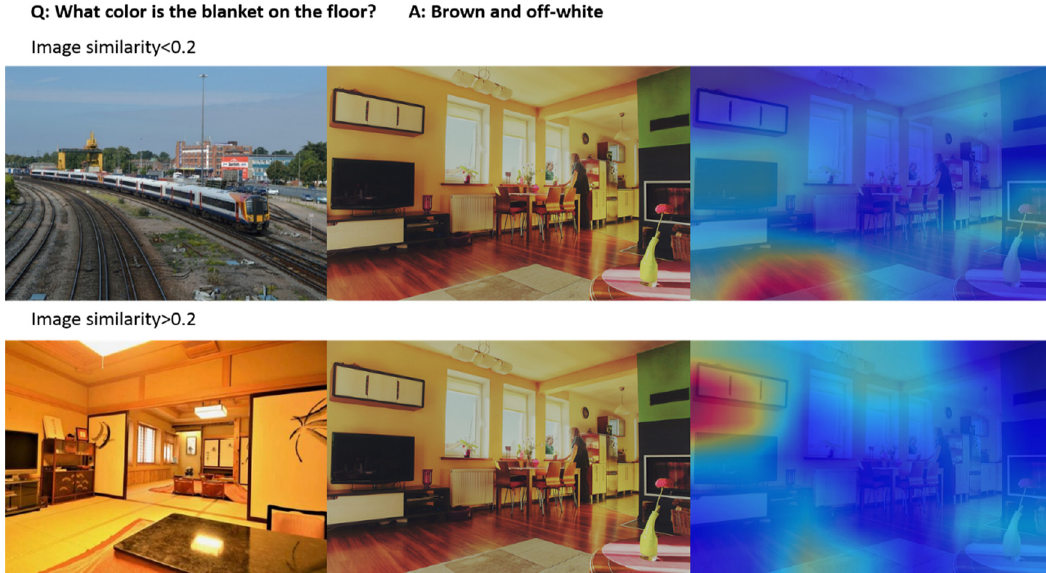
Figure 4. Comparison of the influence of image similarity on attention mechanism.